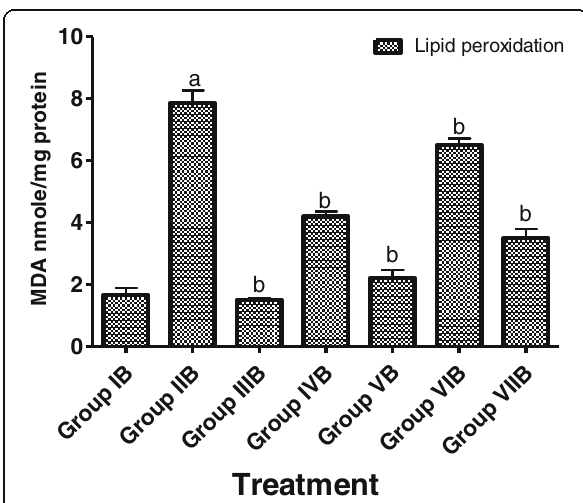
Fig. 8 Effect of methanol extract of T. conophorum seeds on lipid peroxidation levels in CCl 4 induced hepatotoxicity in rats after 48 h of intoxication. Values are Mean ± SEM, n = 5 rats in each group. p < 0.05, a as compared with the normal control group; b as